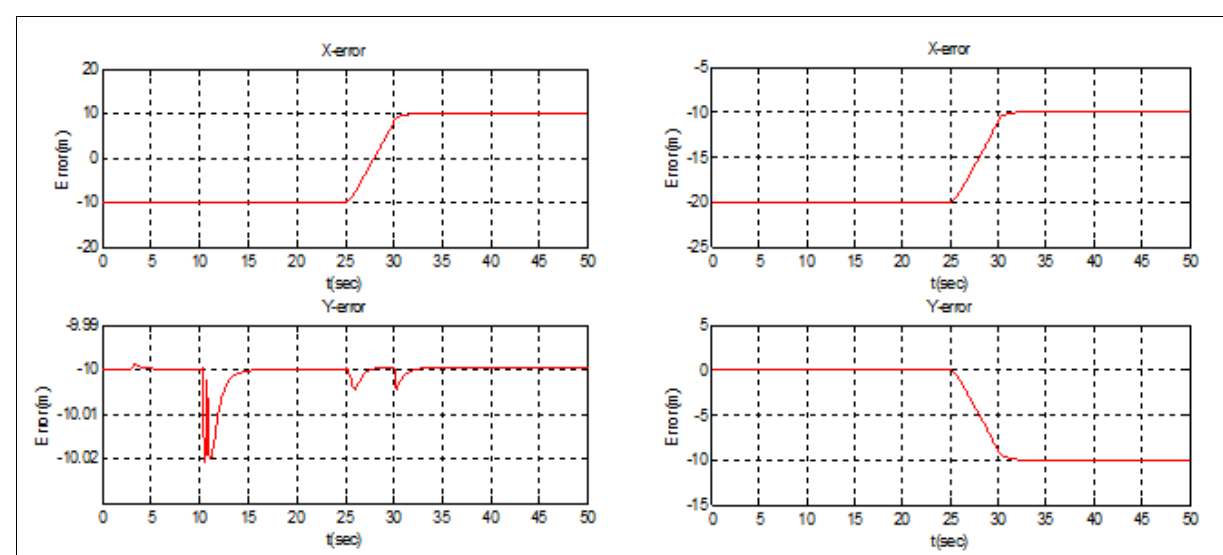
Figure 10. Leader election Case 2—tracking